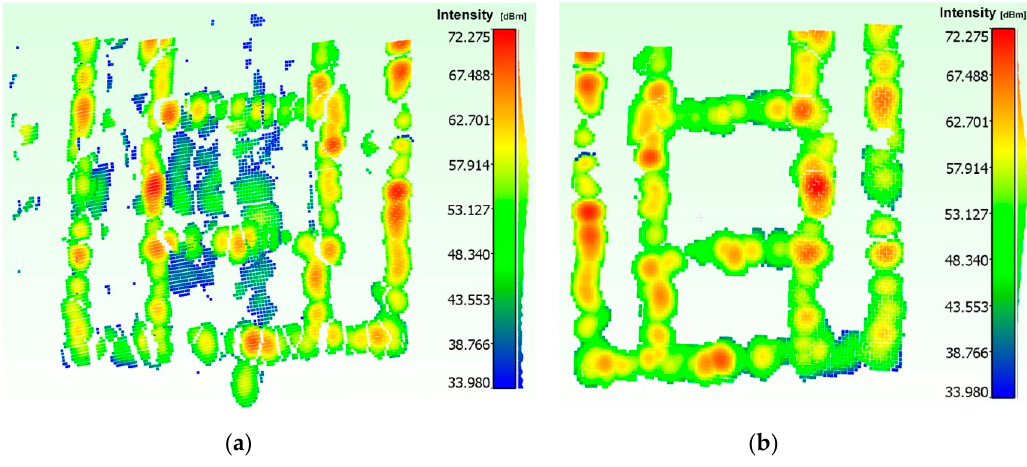
Figure 11. Acoustic 3D point cloud: before ( a ) and after filtering and segmentation stage ( b ).